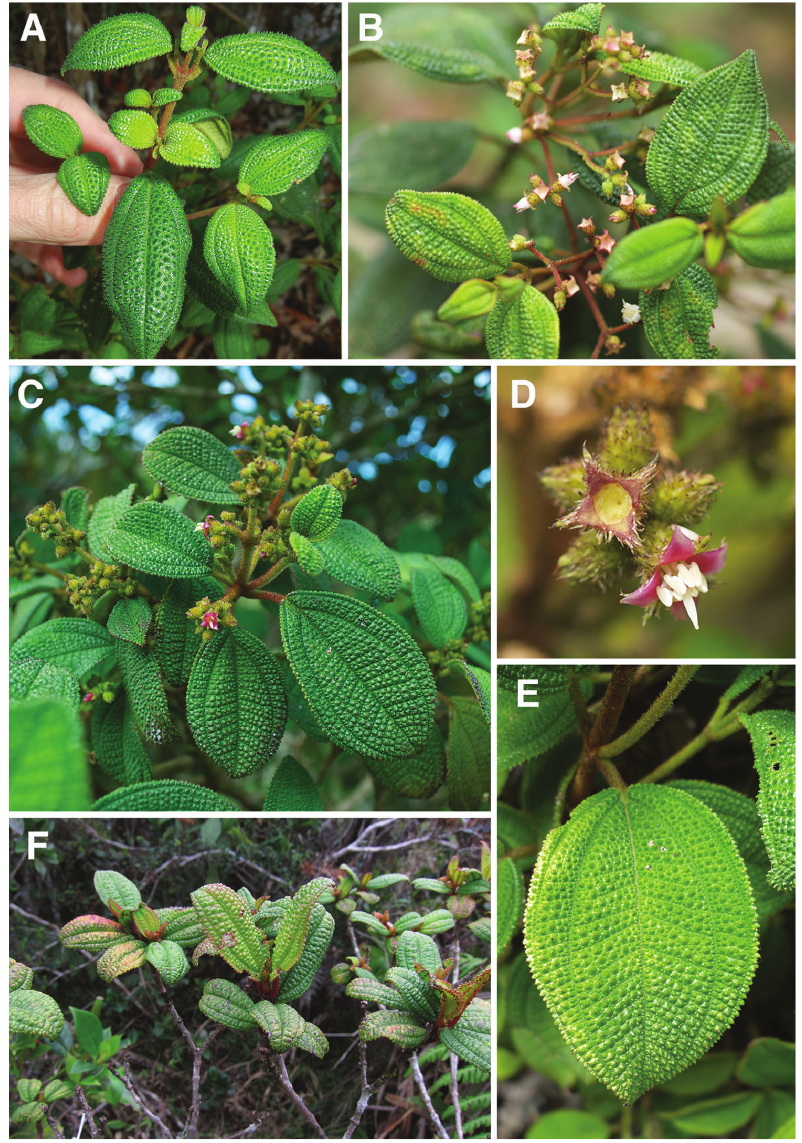
Figure 20. Photos of Miconia lima ( A–E ) and Miconia pagnolensis ( F ). A Miconia lima from Massif de la Selle, Haiti showing habit and ascending stem hairs ( Majure 4334 ) B expanded infloresence and flow- ers showing whitish-pink petals (Sierra de Bahoruco, DR; Skean 4312 ), C–E ) “Monteada Nueva” form of M. lima from the Dominican Republic C habit, inflorescence structure and stem showing ascending hairs ( Majure 5960 ) D flower with dark pink petals showing an thers with a dorso-basal appendage and immature fruit with pinkish calyx lobes E leaf adaxial surface and stem with ascending hairs ( D–E from Judd 8083 ) F Miconia pagnolensis sp. nov. from the type specimen showing habit and bulla-based hairs of the adaxial leaf surface ( Timyan 27 ). Photos A and C taken by L.C. Majure, B by J.D. Skean, Jr., D–E by W.S. Judd and F by J.